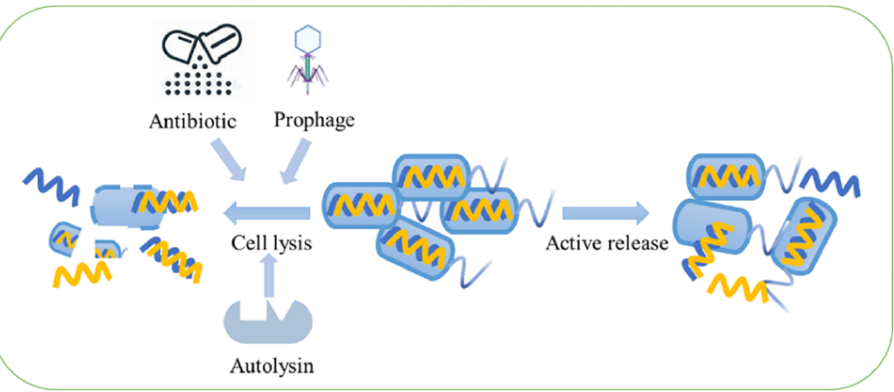
Figure 1. The origin of eDNA. Two pathways are included in eDNA release; one is the lysis-dependent way, and the other is the lysis-independent way.